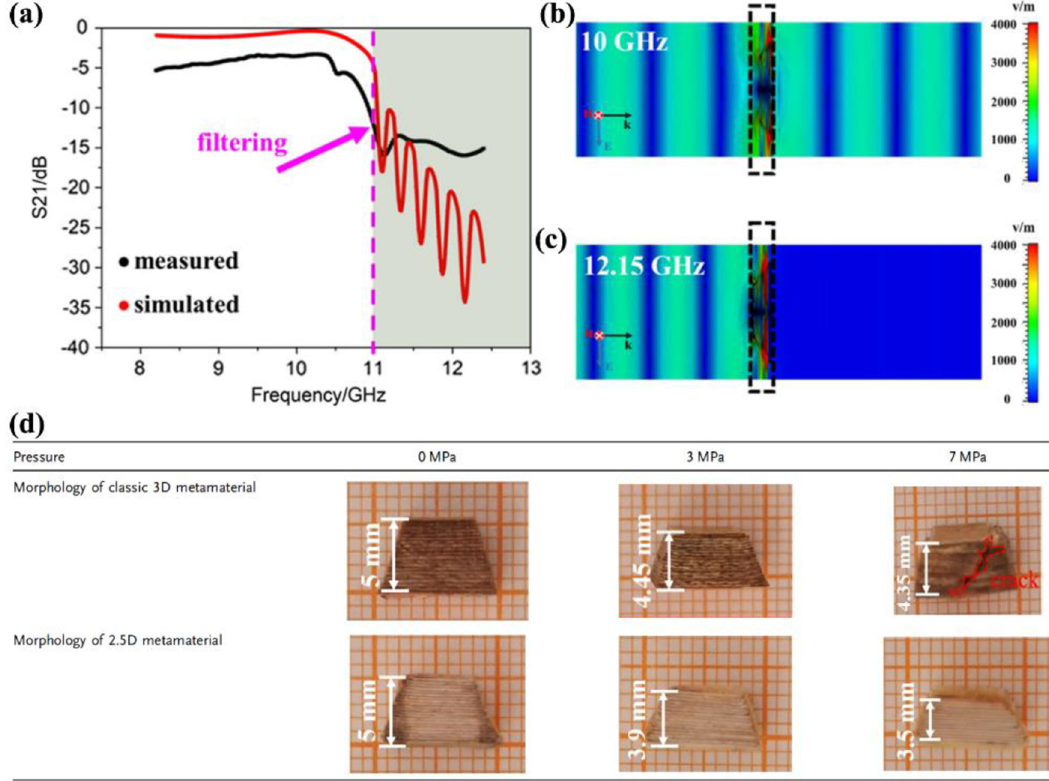
Fig. 12. (a) Simulated and experimental transmission spectra of the 2.5D paper-based metamaterials. Electric amplitude at (b) 10 and (c) 12.15 GHz. (d) The Morphology comparison of 2.5D and 3D metamaterials under different pressures [91]. Reproduced with permission from X. Fu et al., Adv. Eng. Mater. 22 , 1901126 (2020). Copyright 2020 Wiley. (This fi gure is subject to